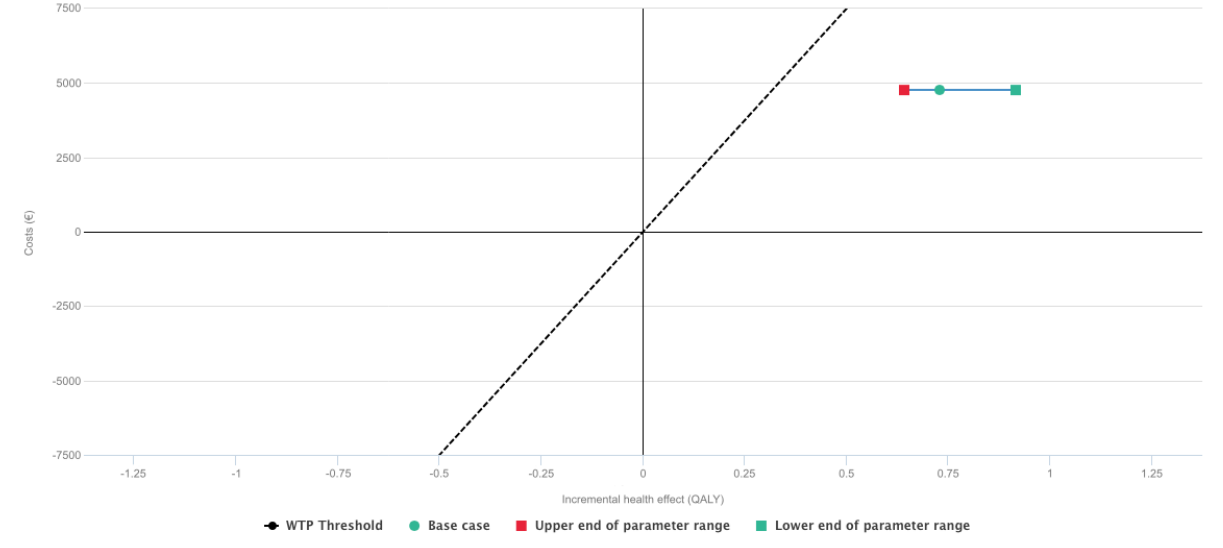
Figure 4. Sensitivity analysis showing effects between 0% and 5% change in utilities—willingness-to-pay of €15,000 (approximately US